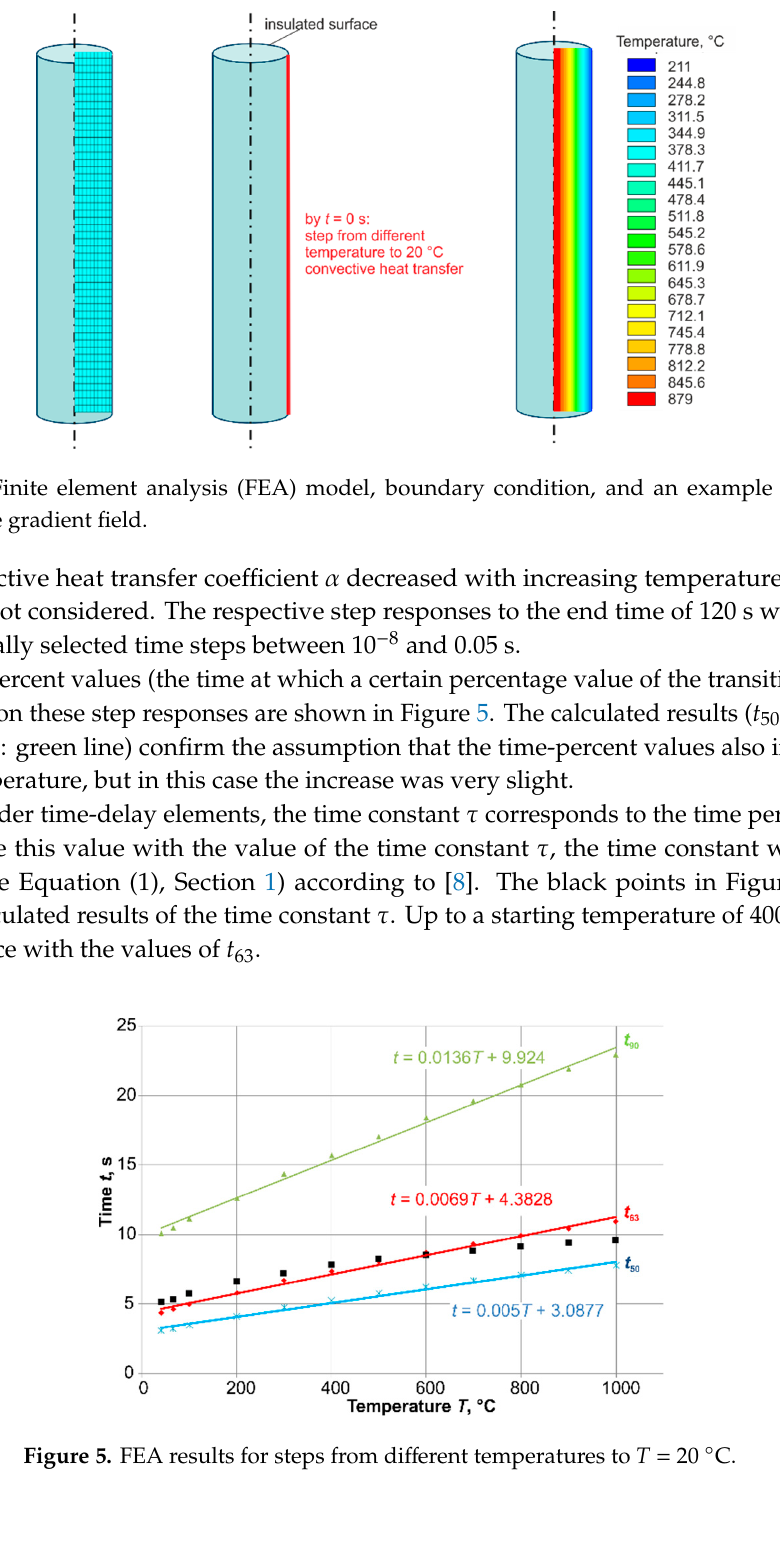
Figure 6. Comparison of FEA and experimental results (Me). The results were compared with experiments for steps from T = 40 °C and T = 65 °C (Figure 6). Due to the design and the material data of the sensor, the experiments could only be carried out in this temperature range. The results in Figure 6 show a good correlation between the calculated and the measured time-percent values in this small temperature range. 4. Investigations with Typical Industrial Thermometers Firstly, the dynamic behavior of a simple sensor element at higher temperatures was investigated. Later, another sensor was mounted in a measuring insert as protection against higher air velocities (Figure 7). The measuring insert has holes at its tip to shorten the time constant compared to conventional measuring inserts.